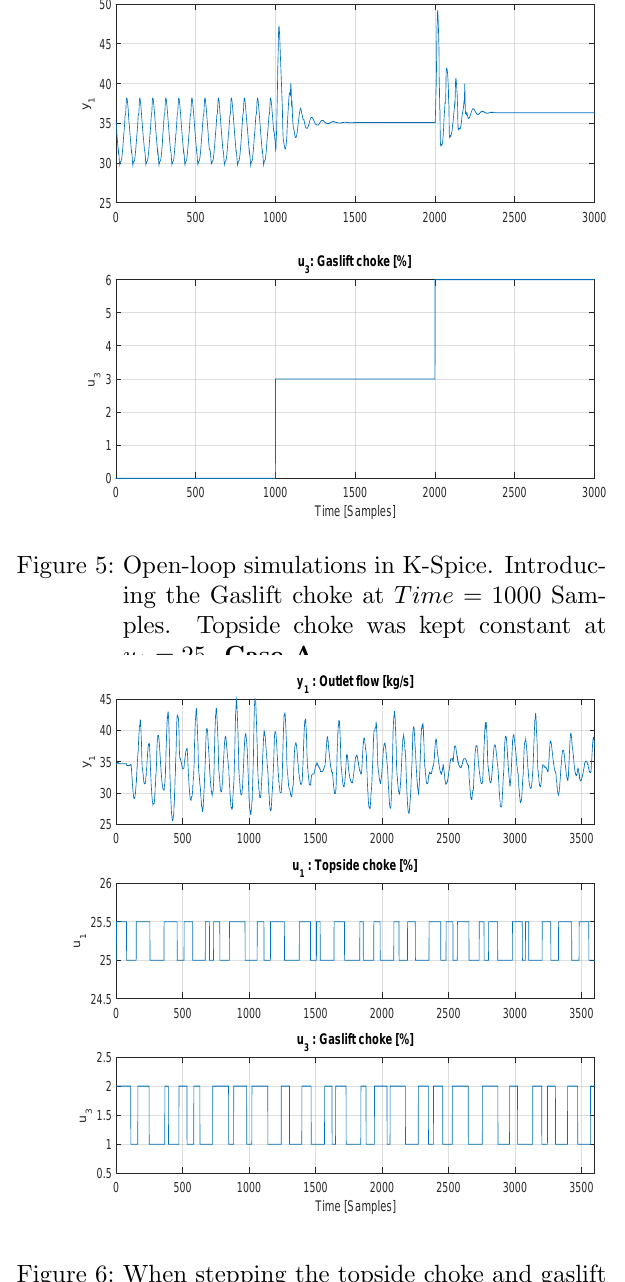
Figure 6: When stepping the topside choke and gaslift valve, the input and output series were col- lected from the K-Spice model, with a length of N = 3600 samples. These inputs are from an experimental design, i.e. PRBS as in Eq. 6 where T min = 20 and T max = 120. These results are from a MATLAB script associated with the block diagram in Fig. 2. The sim- ulation speed in K-Spice was 30 times real time. Case